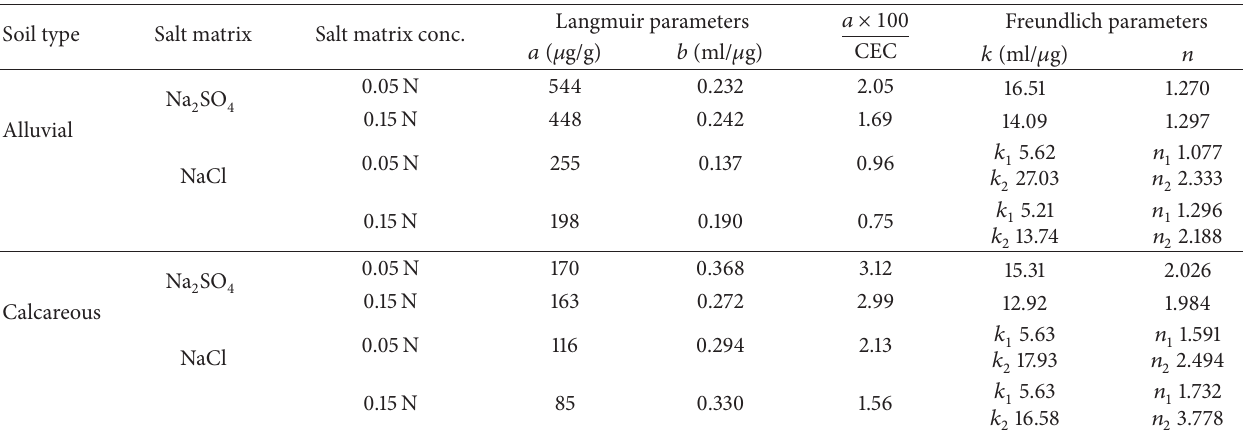
Table 2: The Langmuir and Freundlich coefficients for the two examined soils under different conditions of salt matrix and concentration. Soil type Salt matrix Salt matrix conc.